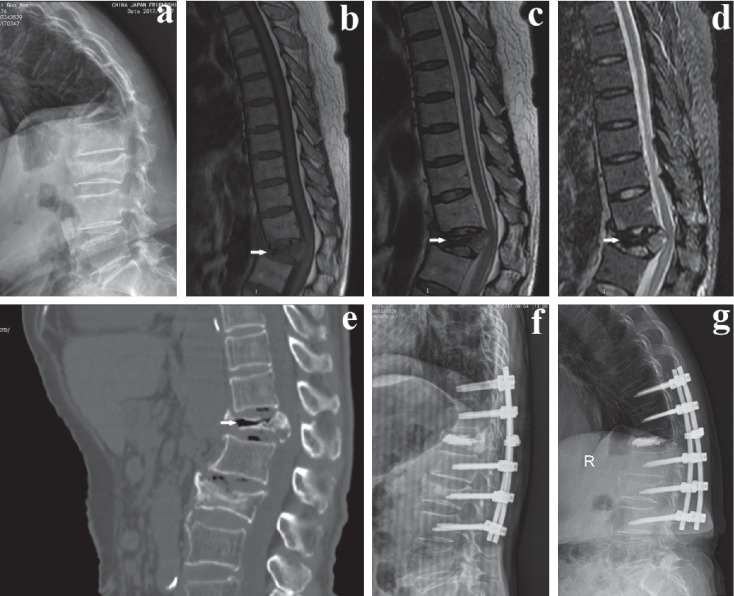
A 76-year-old male patient underwent PFVP because of L1 OVCFs with IVC complicated by neurological deficits. (a–e) Preoperative sagittal plain radiographs, T1- and T2-weighted MRI, STIR MRI, and CT showed an IVC and spinal cord compression at the L1 level with a collapsed fracture and kyphosis. (f) Immediate postoperative plain radiographs showed bone cement in the vertebral body with increased anterior vertebral height and resolved kyphosis. (g) Lateral radiographs showed kyphosis recurrence after 2 years.